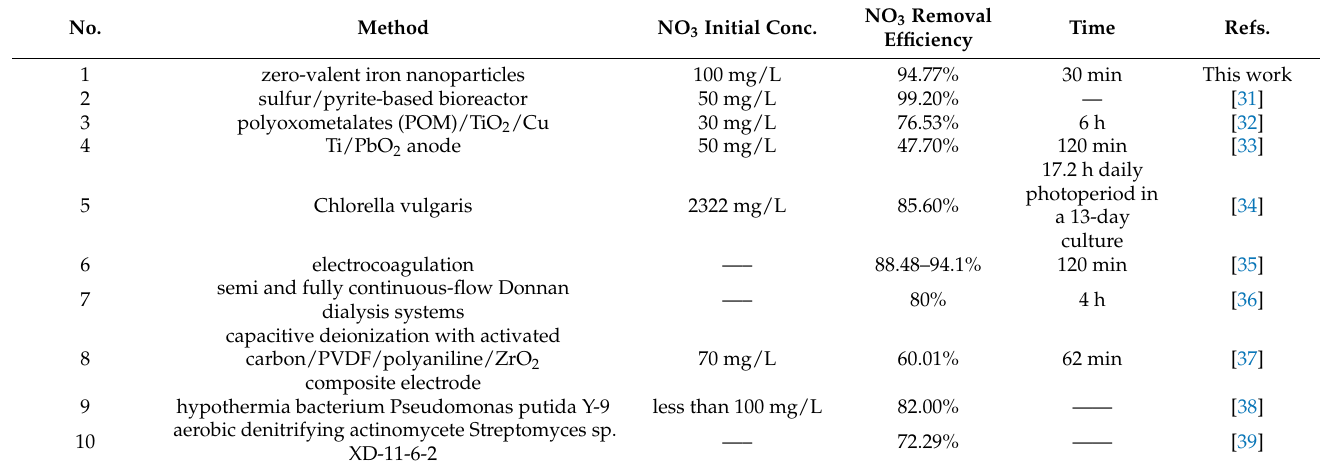
Table 2. Optimum parameters for nitrate removal by different adsorbents and